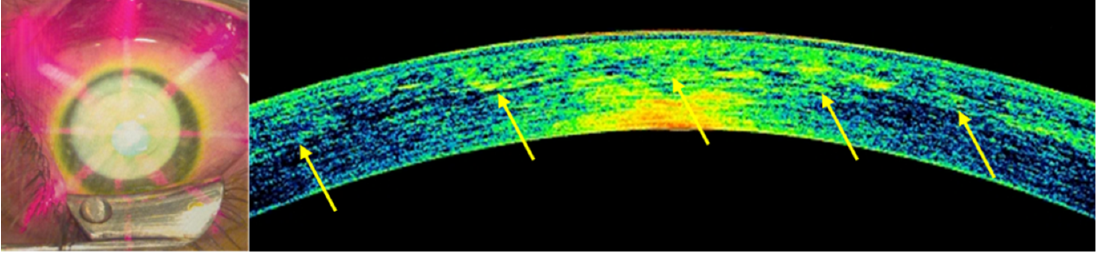
Figure 5. The postoperative spectral-domain corneal OCT performed one month after the treatments revealed a clear demarcation line (yellow arrows) with a mean depth of 278 ± 32 µm. No adverse events such as haze or infections were recorded during the follow-up, except for two cases of paracentral apical de-epithelialization requiring aa therapeutic soft contact lens bandage for 72 h. A punctate epitheliopathy was found in all cases at fluores- cein dye test resolving after 24 to 48 h with a soft contact lens bandage and lubricants. According to the Visual Analogue Scale (VAS) pain scale, the average value as reported in our series was 5 ± 2 in the first 4–6 postoperative hours was 5 (from mild to moderate pain), rapidly dropping to 0 (no pain) after the fifth to the sixth postoperative hour. 4. Discussion The 3-year results of the EFPL M CXL meet the goal of improving the efficiency and feasibility of the Epi-On CXL. The fact that trans-epithelial protocols are considered worldwide the “ way to go of CXL ” is largely based on their benefits in eliminating the risk of infectious keratitis, the stimulation of stromal scarring, and consequent extreme thin- ning, speeding up the functional patient recovery, reducing the postoperative pain dura- tion, and minimizing the microstructural damage to the ocular surface, thus quickly reha- bilitating the patient to study and work activities in a few days [6–8]. Moreover, this treat- ment allows for the possibility of carrying out the procedure comfortably in outpatient mode while reducing the invasiveness and adjunctive kit costs, see Table 3. Nevertheless, in consideration of the high safety profile in the absence of ascertained clinical worsening, this protocol paves the way to the preventive use of crosslinking and to bilateral simulta- neous treatments, also in combination with Epi-off CXL performed in the worst eye. The novelty of this EFPL M TECXL protocol is the use of chemically enhanced 0.25% and 0.22 % riboflavin solutions instead of iontophoresis imbibition and without intraoper- ative oxygen supplementation. This simplified Epi-on approach, avoiding iontophoresis and supplementary oxygen kits resulted in being less invasive and more cost-effective, also offering the possibility of a full outpatient treatment, thus optimizing the clinic work- flow. What is known is that the epithelium shield for short UV-A radiations at the 370 nm waveband is 30%, so by increasing the fluence at 7 J (30% over the standard 5.4 J set in the Dresden protocol), we compensated the epithelial UV-A photo-absorption. Moreover, we also know that epithelium oxygen consumption is around 40%, so including the pulsed light while increasing the fluence and the concentration of the riboflavin solution at 0.25% and 0.22%, respectively, we enhanced the aerobic and anaerobic kinetic of CXL, increasing its overall physiochemical impact. The results of this study demonstrate that by perform- ing the treatment using 18 mW/cm 2 UV-A power for 12 min and 58 s of UV-A pulsed light exposure, we halted KC progression without adverse events, similarly to the EFPL I-CXL protocol in a 3-year follow-up, of which the present requirements are a simplified evolu- tion that works at air room oxygen conditions [18,19]. On the other hand, we have recently demonstrated that by using 30 mW/cm 2 UV power with a shorter exposure time, the in- traoperative oxygen supplementation enhances the aerobic pathway of CXL, increasing the treatment penetration and corneal flattening [20] . In this case, the 18 mW/cm 2 UV-A